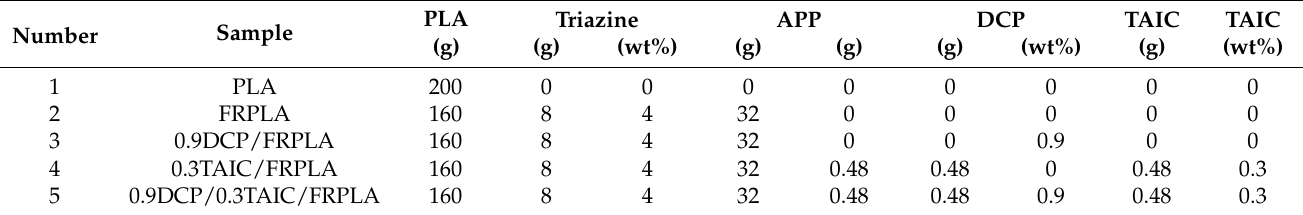
Table 1. Formulations of PLA